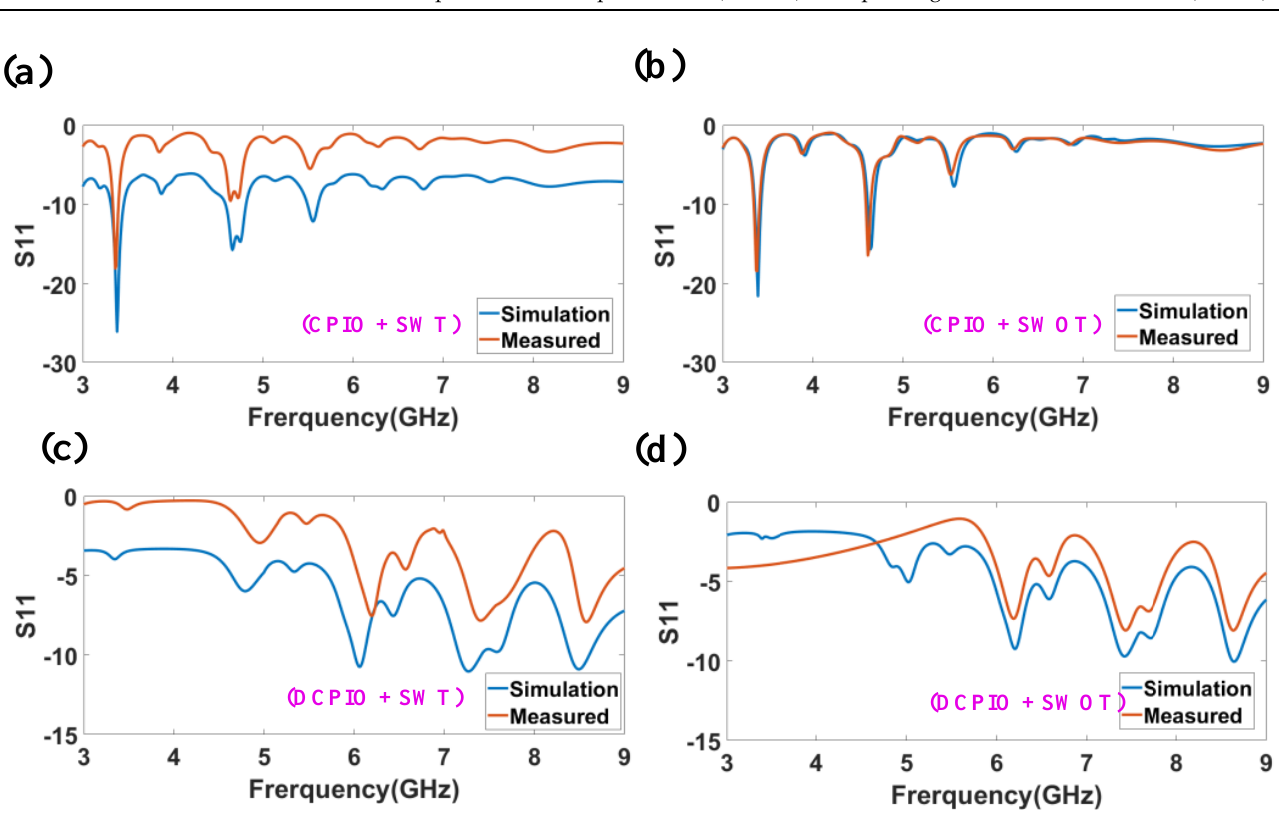
Figure 6. Measured and simulated reflectance response analysis using the FR-4 as substrate. The number of bands for the proposed four structures is 3, 2, 3 and 1. Minimum reflectance responses are, respectively, − 26.11 dB, − 21.52 dB, − 11 dB and − 10.10 dB. The resonance frequency is, respectively, 3.38 GHz, 3.39 GHz, 7.27 GHz and 8.64 GHz. ( a ) CPIO and SWT Design Structure. ( b ) CPIO and SWOT Design Structure. ( c ) DCPIO and SWT Structure. ( d ) DCPIO and SWOT Structure. The voltage standing wave ratio (VSWR) represents how effectively the antenna power propagates through an antenna. Figure 8 (a) represents the VSWR response by choosing the substrate as FR4. The CPIO and SWT antenna structures provide a VSWR of 1.51 at 3.38 GHz. The CPIO and SWOT antenna structures provide a VSWR of 1.18 at 3.39 GHz. The DCPIO and SWT antenna structures provide a VSWR of 1.83 at 7.87 GHz. The DCPIO and SWOT antenna structures provide a VSWR of 2.21 at 8.64 GHz. It is observed that the connected interior and exterior patch (CPIO) design provides a better VSWR than the disconnected interior and exterior patch (DCIOP) design. Data are represented in Table 3. Figure 8b depicts the VSWR response by choosing the substrate as Rogers RT Duroid 5880. The CPIO and SWT antenna structures provide a VSWR of 1.05 at 6.49 GHz. The CPIO and SWOT antenna structures provide a VSWR of 1.03 at 6.52 GHz. The DCPIO and SWT antenna structures provide a VSWR of 2.33 at 8.83 GHz. The DCPIO and SWOT antenna structures provide a VSWR of 5.67 at 8.80 GHz. Data are represented in Table